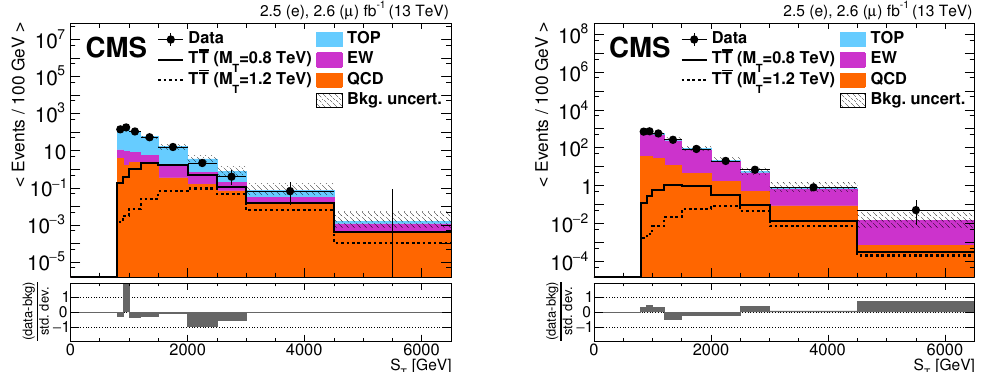
Figure 4 . Distributions of S T in the tt (left) and W + jets (right) control regions of the boosted H channel after applying all corrections to their shape and normalization. The TT signal, shown for T quark masses of 0.8 and 1.2 TeV, is normalized to the theoretical cross section and the singlet benchmark branching fractions are assumed. The uncertainty in the background includes statistical and systematic uncertainties described in section